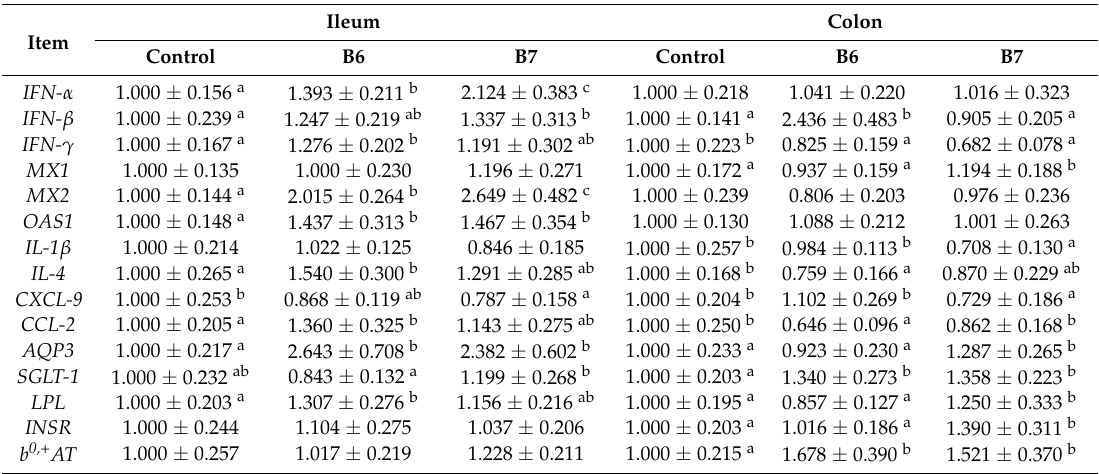
Table 5. Regulation of B. coagulans on the gene expression in the ileum and